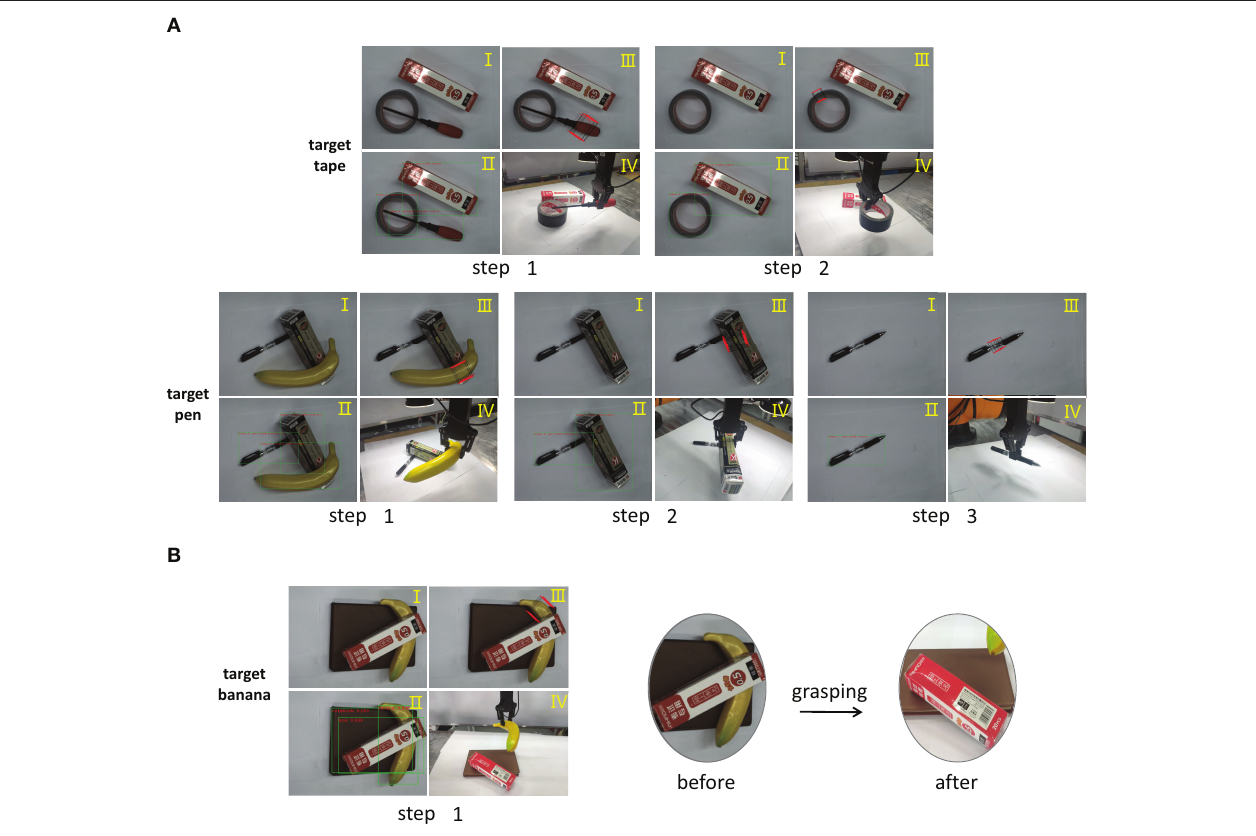
FIGURE 8 | The examples of robot grasping experiment. (A) Grasping with GVMRN, (B) Grasping directly. Each grasping step includes (I) object detection, (II) manipulation relation reasoning, (III) grasping detection, and (IV) grasping the object with the robot arm.